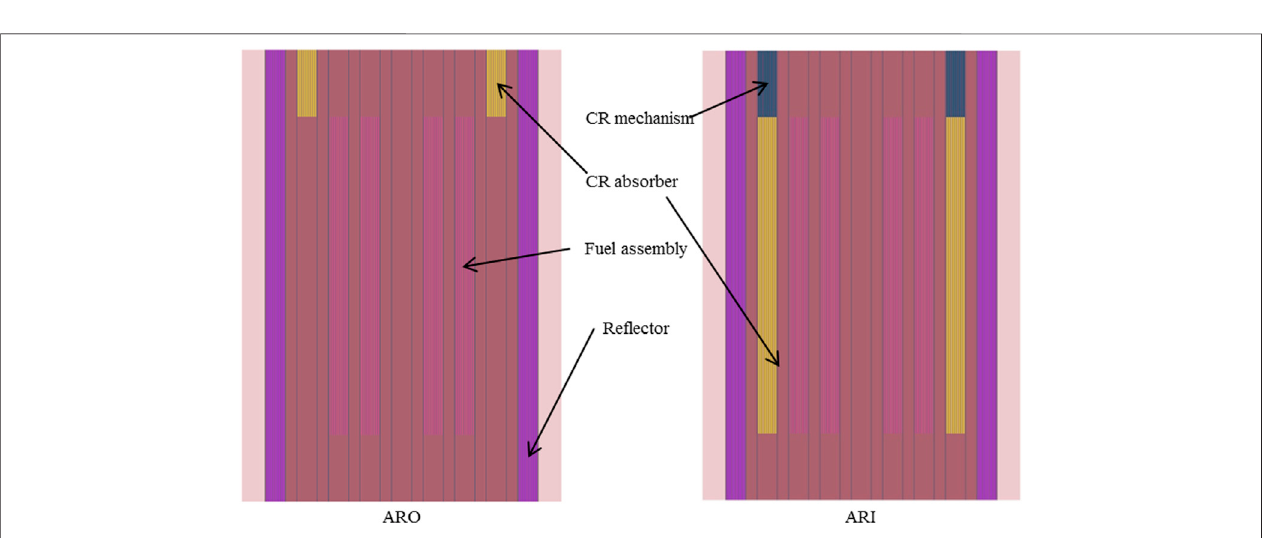
FIGURE 4 | Axial cut of the